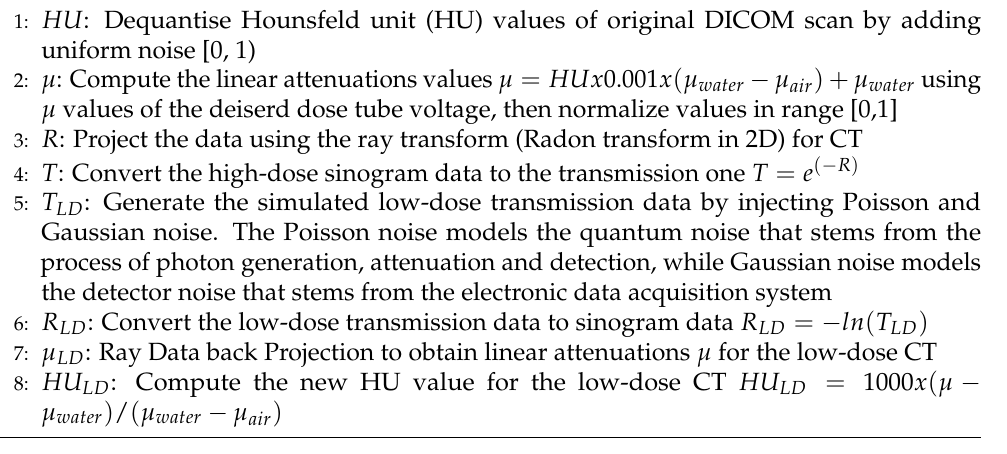
Algorithm 1: Generating LDCT from existing retrospective CT scans